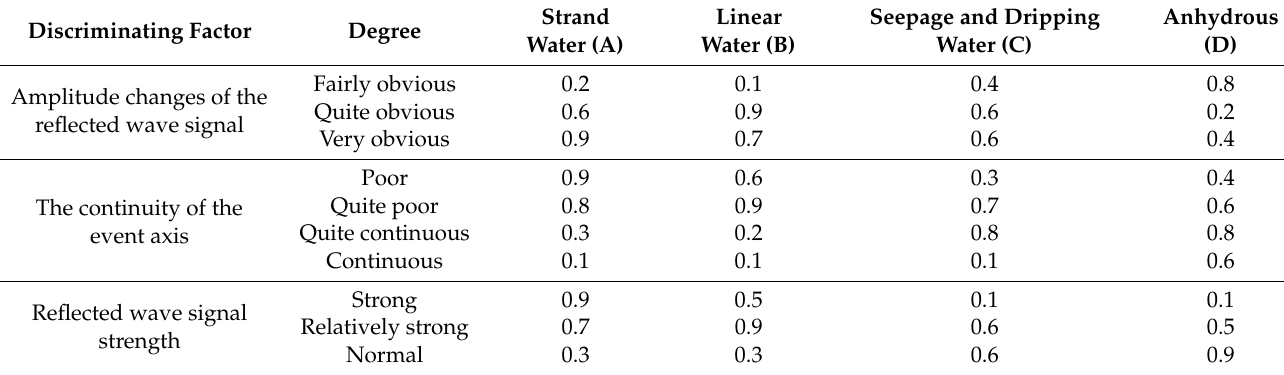
Table 1. Membership degree of GPR identification factors to effluent fuzzy sets.